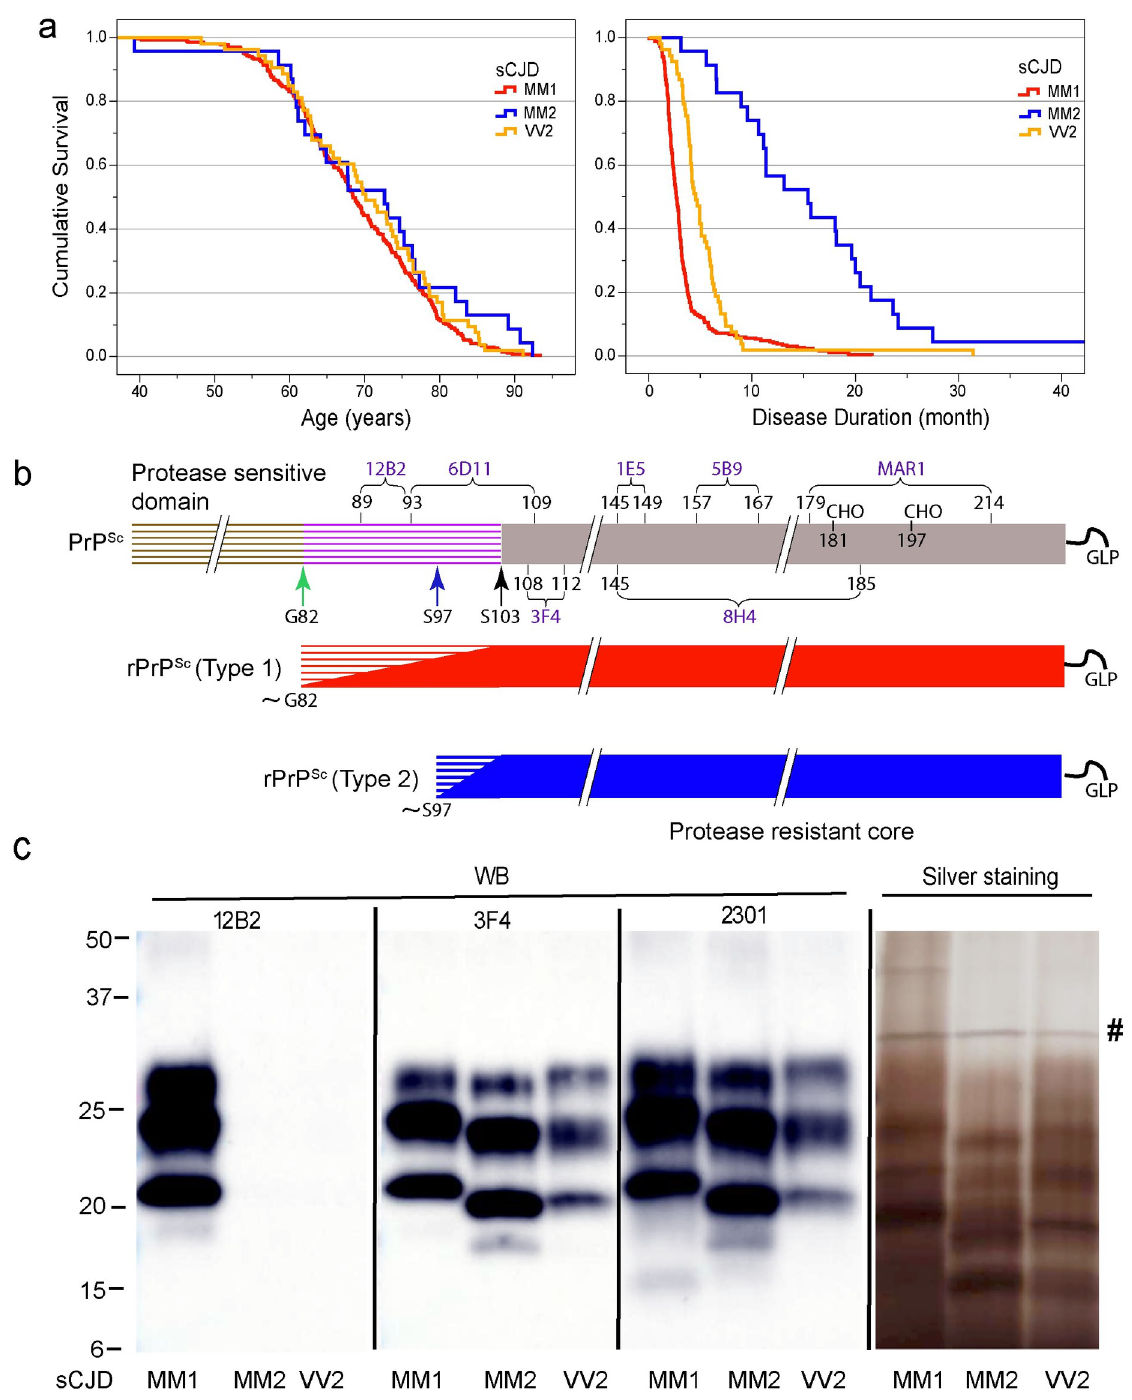
Fig 1. Distinct disease duration, schematic representation, and molecular characteristics of sCJD MM1, MM2, and VV2 prions. ( a ) The age (left panel) and disease duration (right panel) in 343 cases of sporadic CJD MM1, MM2, and VV2 prion disease; ( b ) Outline of classification of Type 1 and Type 2 human prions based on proteolytic fragmentation of PrP Sc [75, 89]. Major cleavage sites by PK are indicated by arrows; GLP–glycolipid; CHO- complex N-glycosylation chains. The codes above light blue brackets represent monoclonal antibodies used in differentiation of various domains of human prions, and the numbers below these brackets indicate linear epitopes recognized by these antibodies. ( c ) Distinct glycosylation and Proteinase K fragmentation patterns of purified human MM1, MM2, and VV2 sCJD rPrP Sc (homozygous for methionine [M] or valine [V] in codon 129) used in structural studies. To differentiate Type 1, Type 2 prions, and their C-terminal fragments, Western blots of purified rPrP Sc (fraction 8; F8) of MM1, MM2, and VV2 sCJD rPrPSc were developed with